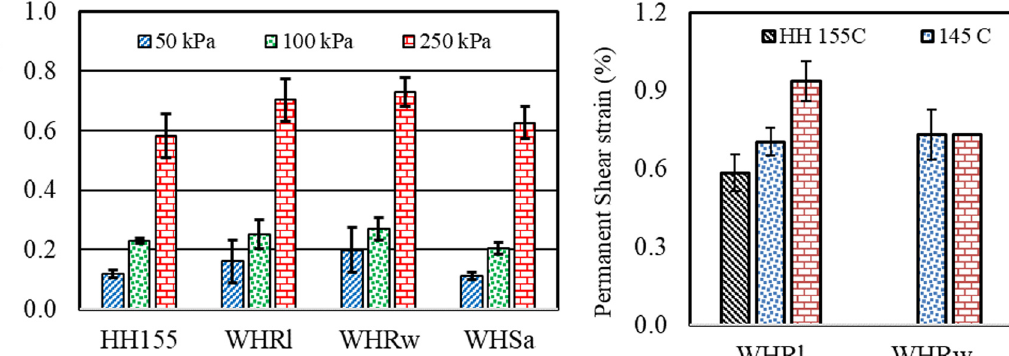
Figure 9: Permanent shear strain at each testing cycle of WMAs manufactured at 145°C.